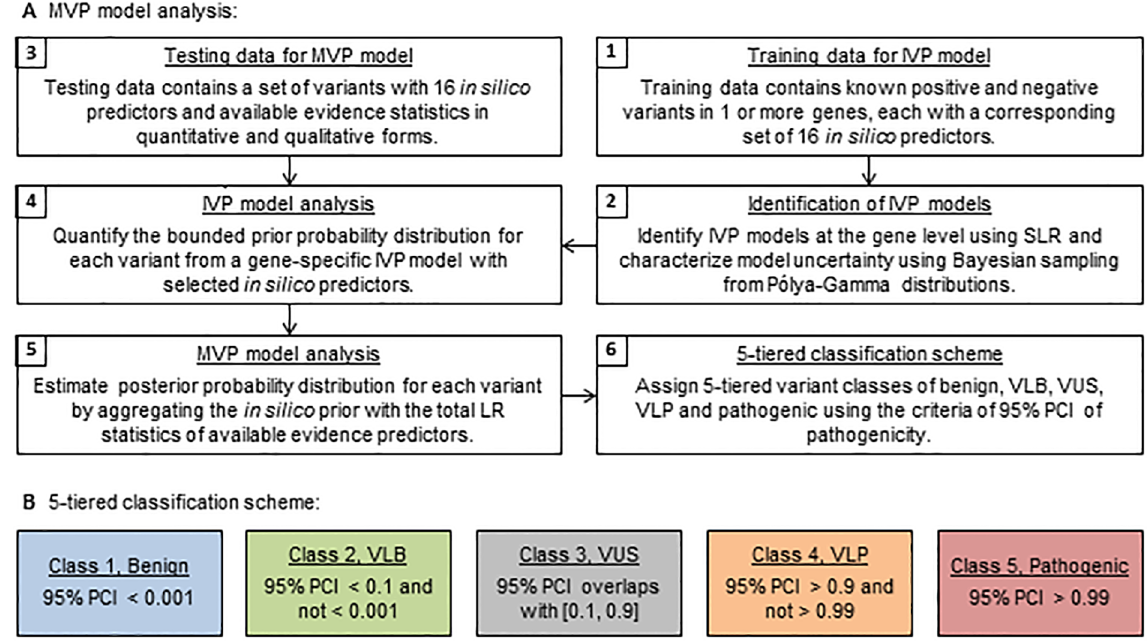
Fig 1. Algorithm modules of multifactorial model analysis for variant prediction and classification. ( A ) Modules of Bayesian multifactorial model analysis for variant prediction and classification. SLR = stepwise logistic regression. ( B ) 5-tiered variant classification scheme based on the estimated 95% probability credible interval (PCI) of variant pathogenicity.